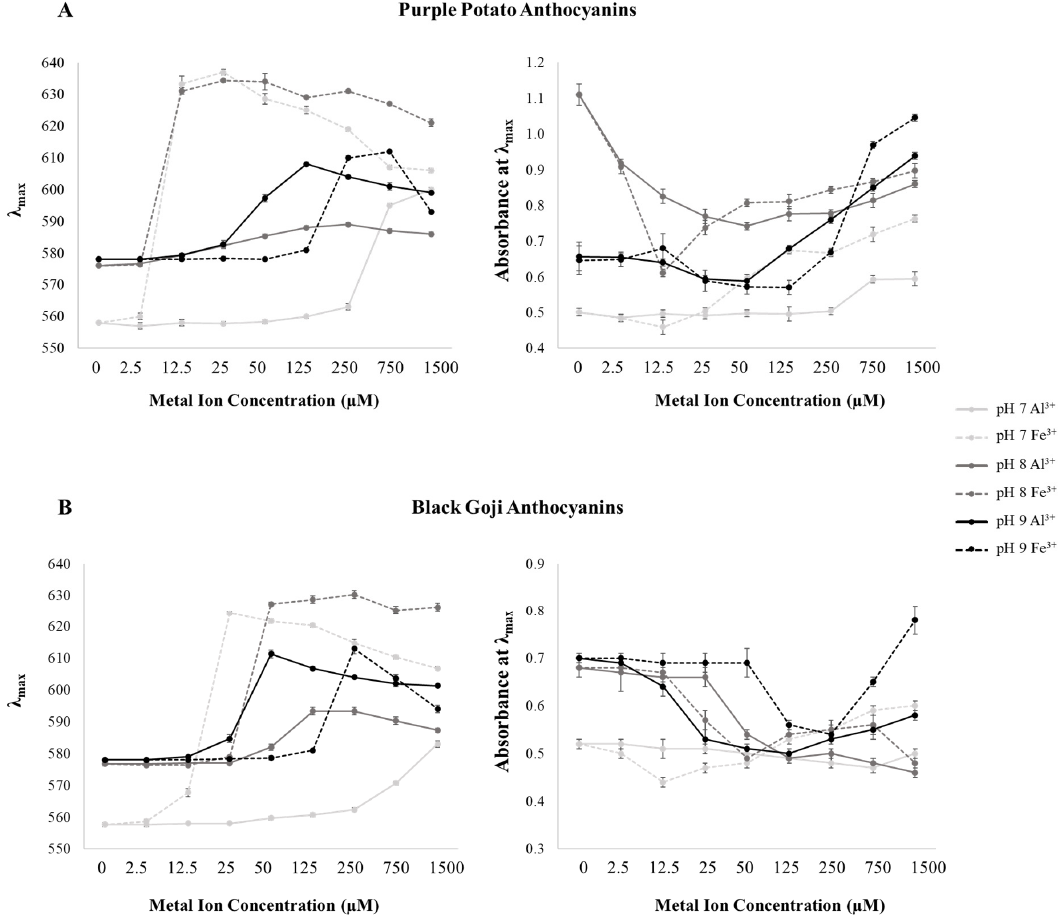
Figure 4. Quantification of spectrophotometric changes in purple potato ( A ) and black goji ( B ) anthocyanin metal chelates. Data were collected 1 hr after the anthocyanins were mixed with metal ions and pH adjustment with the buffers.